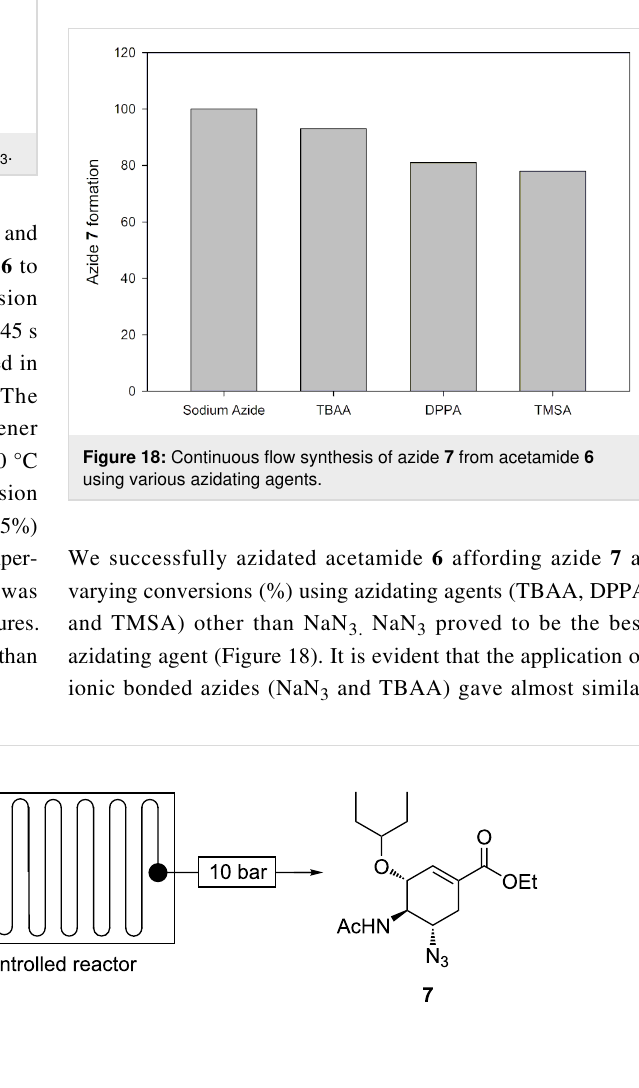
Figure 16: Continuous-flow C-5 azidation of acetamide 6 using NaN 3 .